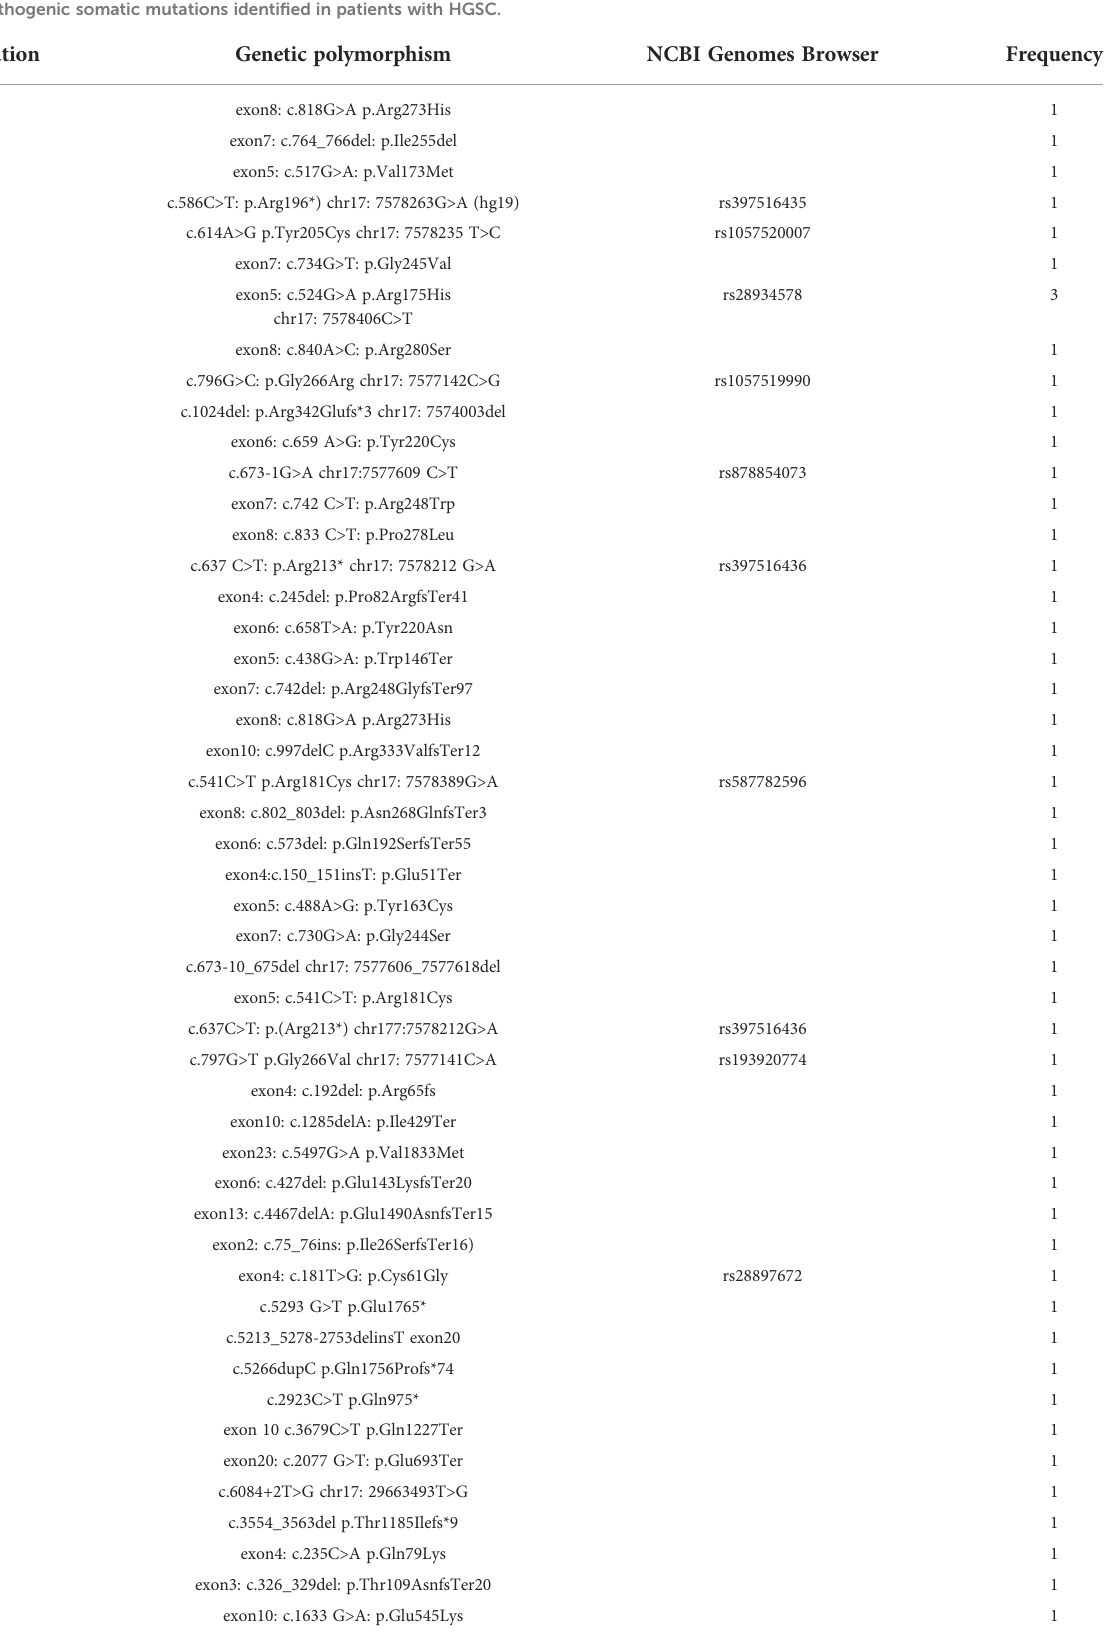
TABLE 1 Pathogenic somatic mutations identi fi ed in patients with